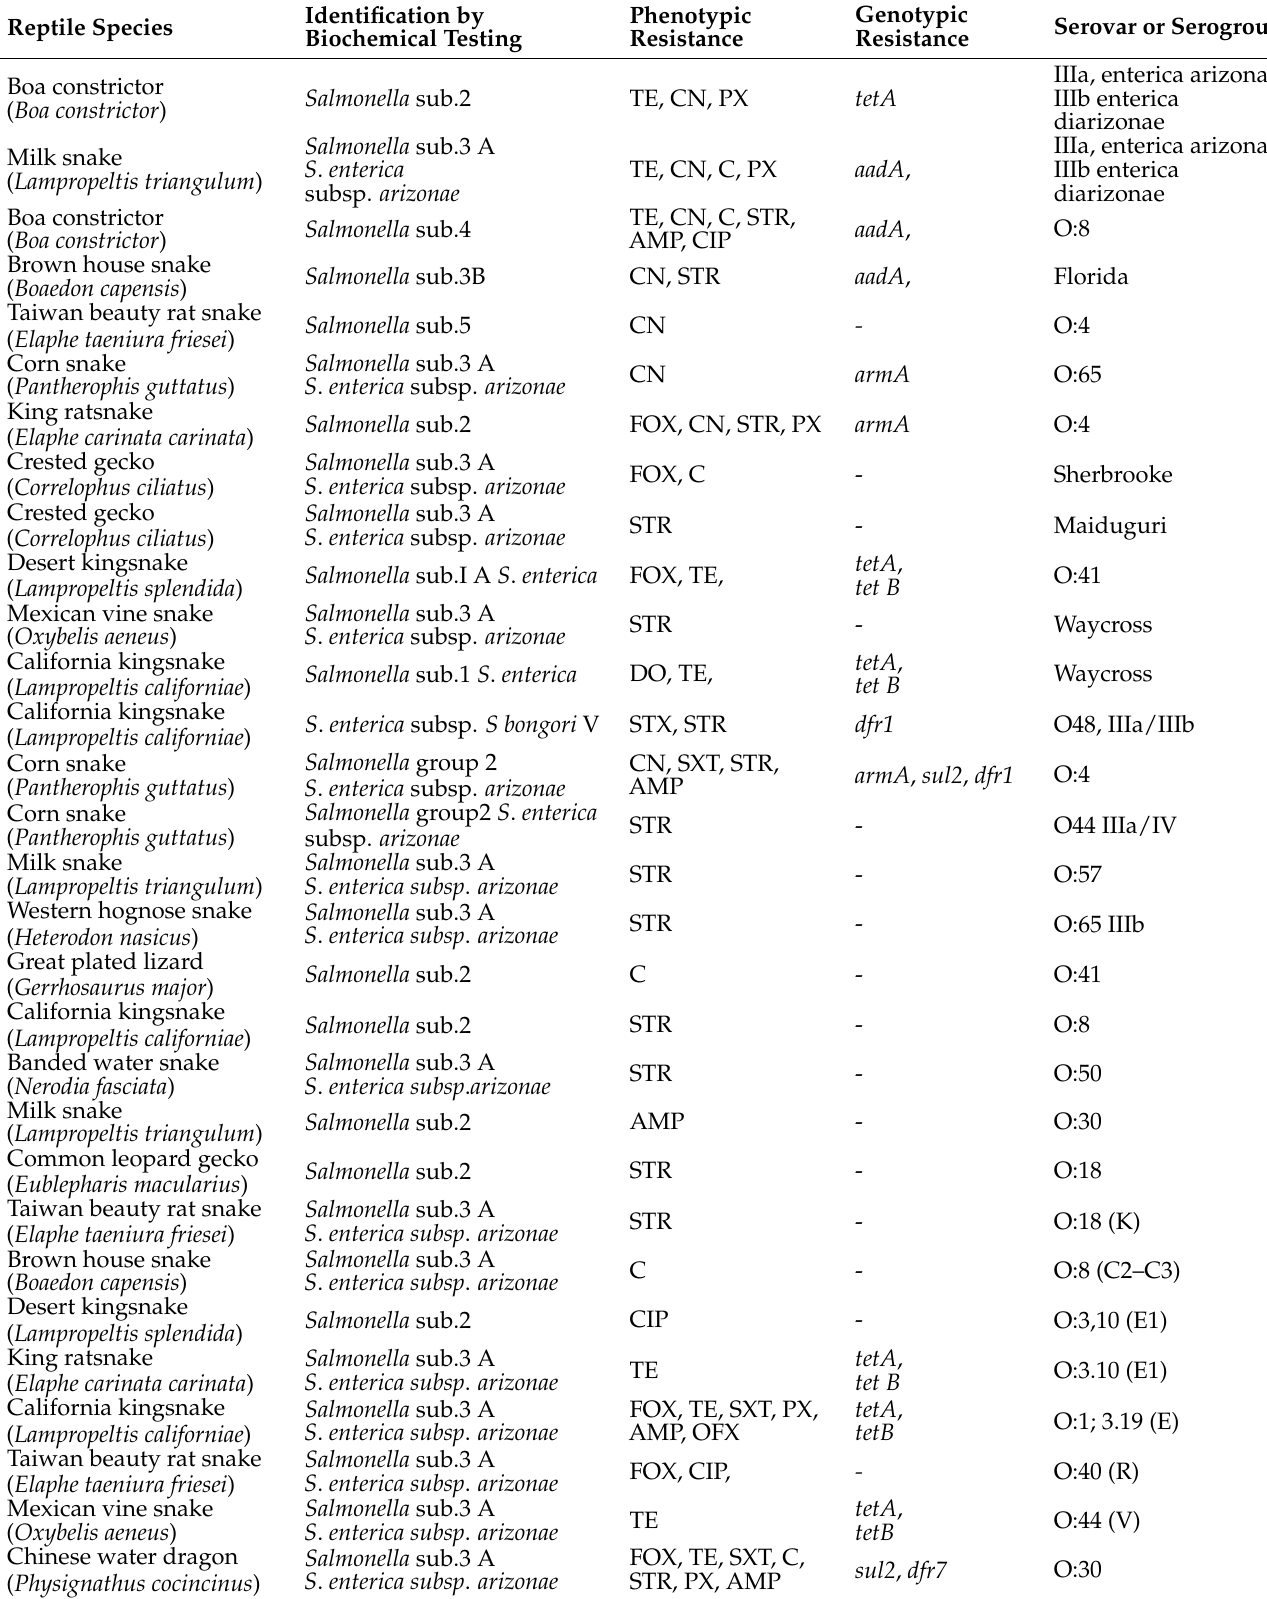
Table 4. Characteristics of Salmonella isolated from domesticated